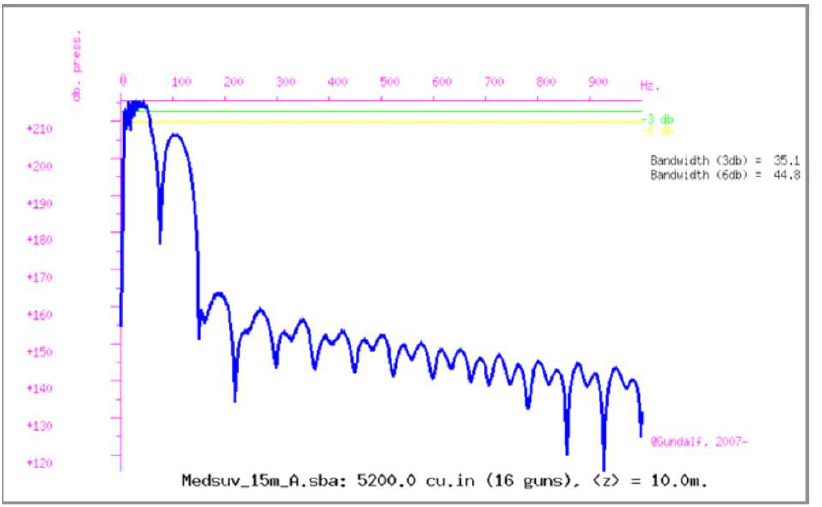
Figure 2. Frequency contents of the active source simulated with the GUNDALF air-gun array modeling program [Gundalf 2012] under the conditions of the TOMO-ETNA experiment.